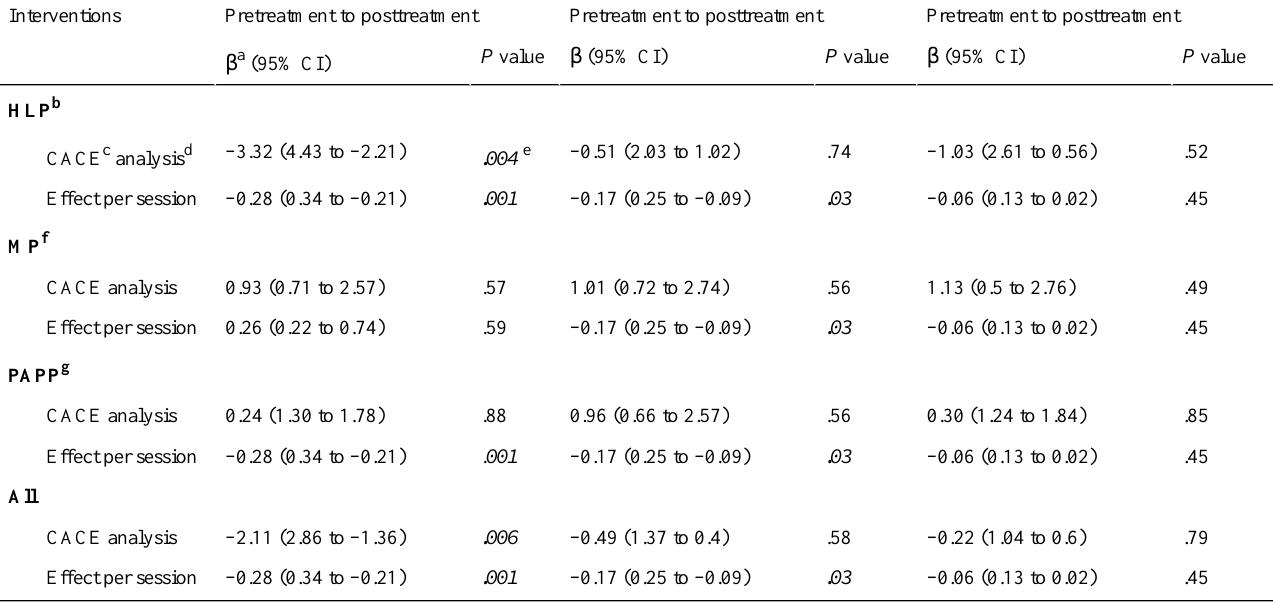
Table 4. Dose-response in imputed primary outcome at posttreatment and along the follow-up.